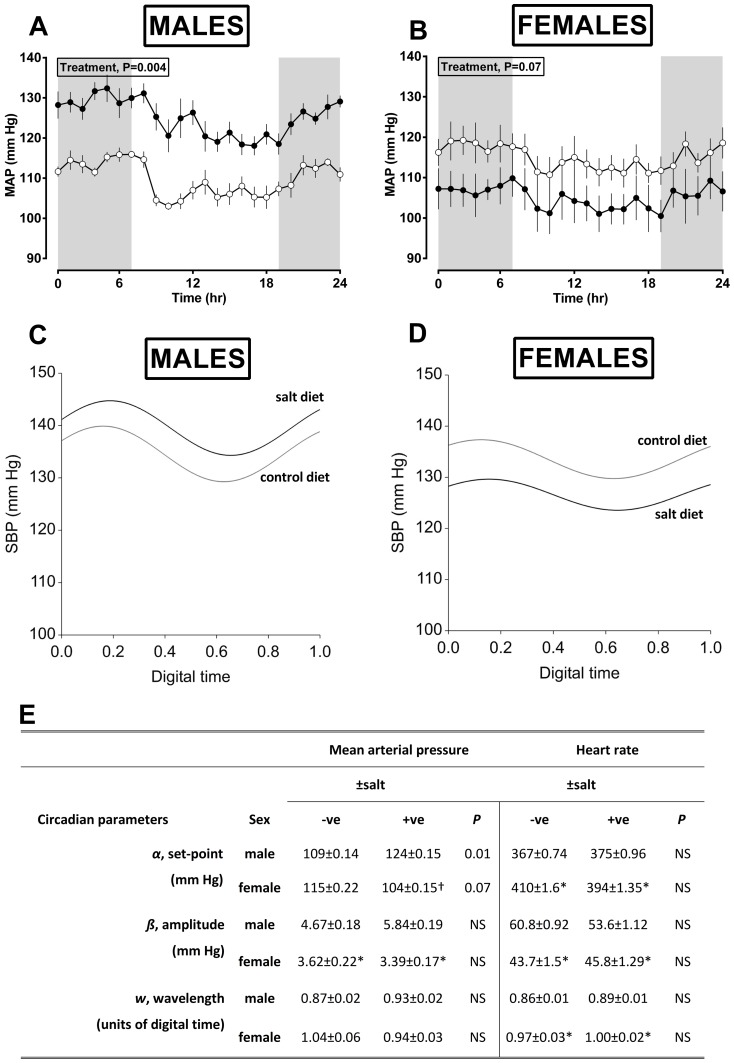
Salt-exposed offspring have increased blood pressure throughout the circadian cycle.For blood pressure, assessed by telemetry, data are from Control diet; n = 6 dams, n = 6/6 [male/female] offspring or high-salt (4% salt) diet; n = 6 dams, n = 5/5 [male/female] offspring. Values are either hourly means (A,B; derived from summary measures of 48 h recording) or the fitted model from non-linear regression [Fourier] analysis of all datapoints recorded over the 48 h period (C,D) and the respective output of circadian parameters from the model (E). Data are predicted means (±S.E.M.) and were analysed by mixed effect models with treatment (control vs. 4% salt) and sex (male vs. female) or their interaction as fixed and dam as a random effect (Genstat v14). NS, not significant.